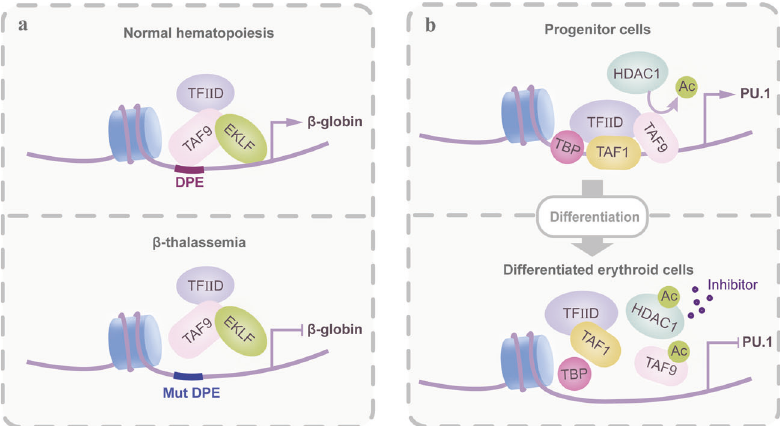
Fig. 1 Modes of gene transcriptional regulation by TAF-containing TCs. A deeper insight into the functional importance of TAFs as cofactors that connect transcription complexes with DNA. In addition, other cofactors within one transcription complex could indirectly affect gene transcription via regulating TAFs. a As a component of TFIID, TAF9 associated with the transcription factor EKLF provides a platform for the recruitment of TFIID transcription complexes, particularly at promoters that contain the initiator (INI) and DPE box (i.e., β -globin promoter). In disease conditions, β -thalassemia-causing mutations across the binding region disrupt the formation of the transcription complex and thus generally inhibit transcription ef fi ciency. b The DNA-binding ability and activity of TAF9 are determined by its acetylation level. During erythropoiesis, TAF9 acetylation gradually increases due to a decrease in HDAC1-associated deacetylase activity, which subsequently results in the disassociation of the TFIID complex and transcriptional